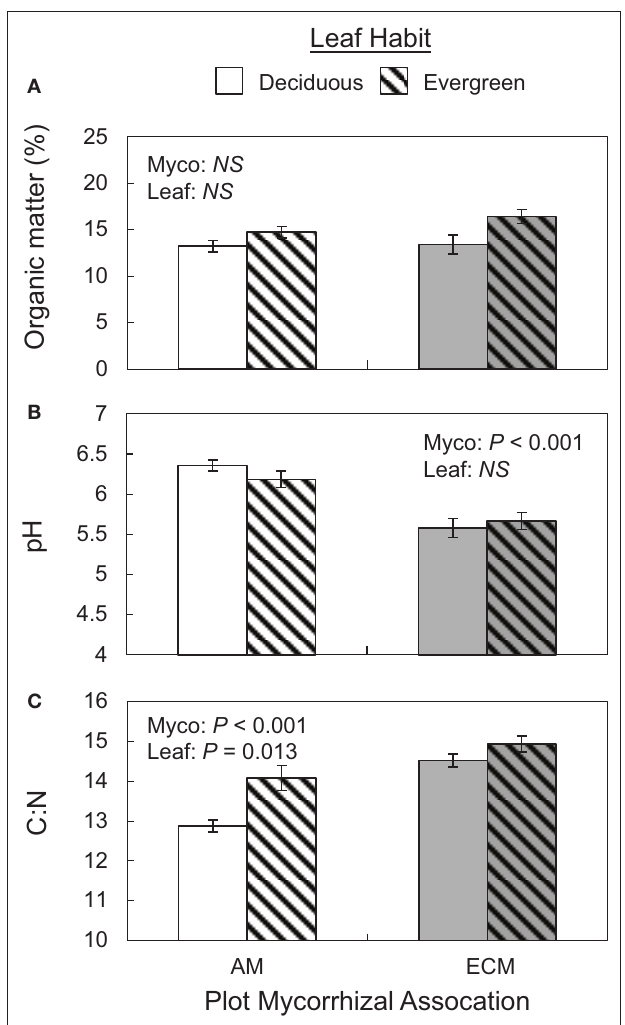
FIGURE 2 | Soil organic matter content (A) , pH (B) , and C:N ratios (C) in forestry plots at The Morton Arboretum. Bars are mean ratios; one standard error of the mean is presented. Open bars, deciduous plots; hatched bars, evergreen plots; white bars, AM plots; gray bars, ECM